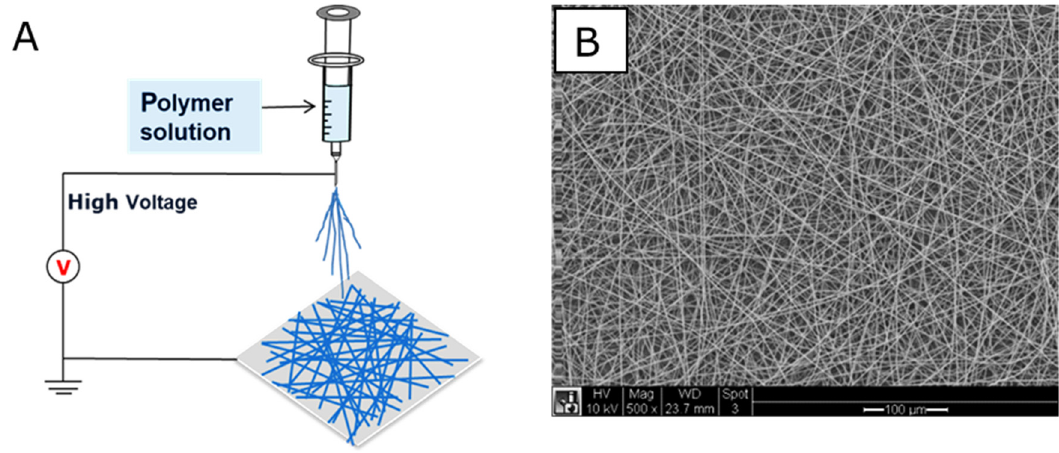
Figure 4. Schematic ( A ) of a typical electrospinning system, and SEM image; ( B ) of electrospun nanofibrous structure.